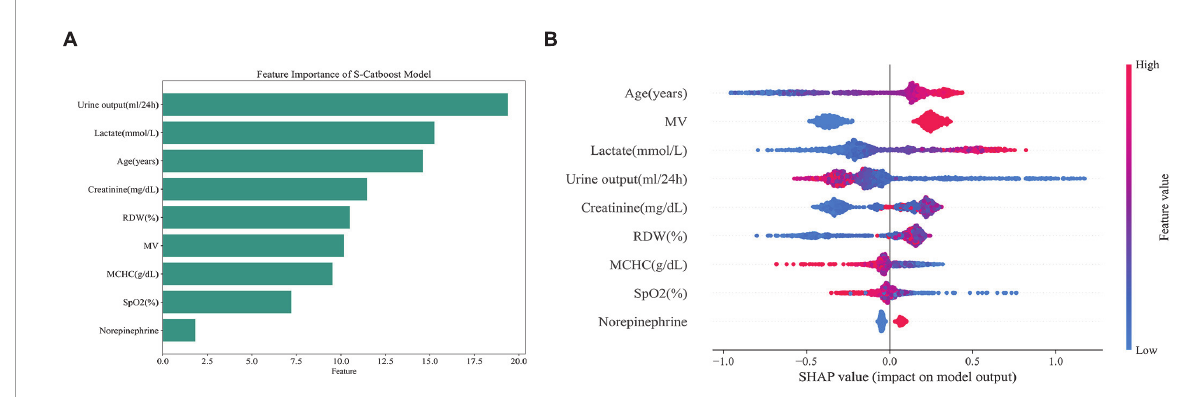
FIGURE5 Feature importance ranking of S-Catboost model. (A) Feature importance ranking based on S-CatBoost; (B) feature importance ranking based on the SHAP value. The vertical axis is from top to bottom, and the importance of features decreases. The position of the point on the horizontal axis indicates the feature’s influence on the model’s predicted value, and the point’s color reflects the feature’s value. For the numerical variable, the blue and red points represent lower and higher values; for categorical variables, blue and red dots correspond to yes or no, respectively. S-Catboost, simplified Catboost model; MV, mechanical ventilation; SPO2, saturation of pulse oxygen; MCHC, mean corpuscular hemoglobin concentration; RDW, red blood cell distribution